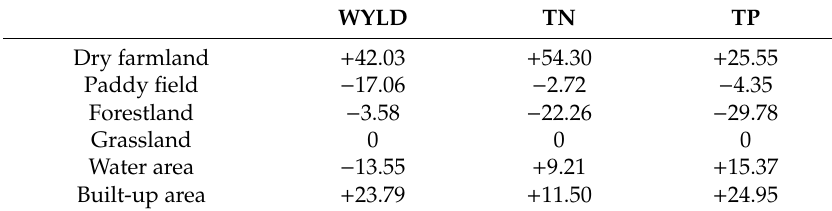
Table 3. Summary of the relative contributions of land use changes in the boosted regression tree (BRT) models for water yield (WYLD), total nitrogen (TN), and total phosphorus (TP). WYLD TN TP Dry farmland + 42.03 + 54.30 + 25.55 Paddy field − 17.06 − 2.72 − 4.35 Forestland − 3.58 − 22.26 − 29.78 Grassland 0 0 0 Water area − 13.55 + 9.21 + 15.37 Built-up area + 23.79 + 11.50 + 24.95